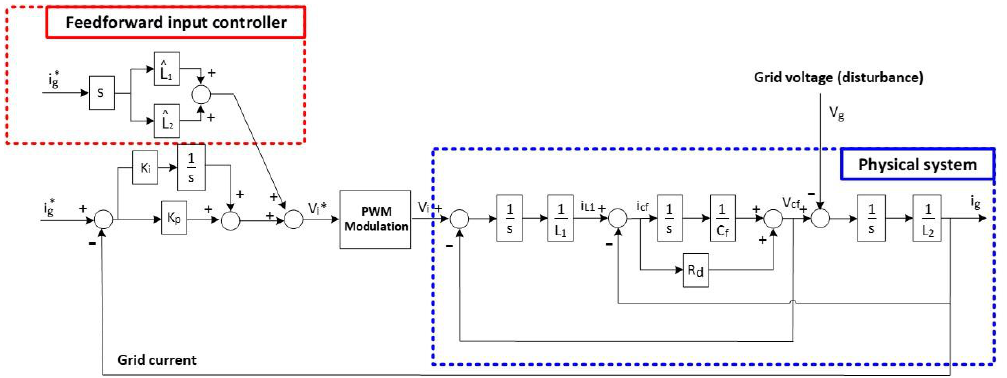
Figure 2. A system block diagram with command feedforward control.